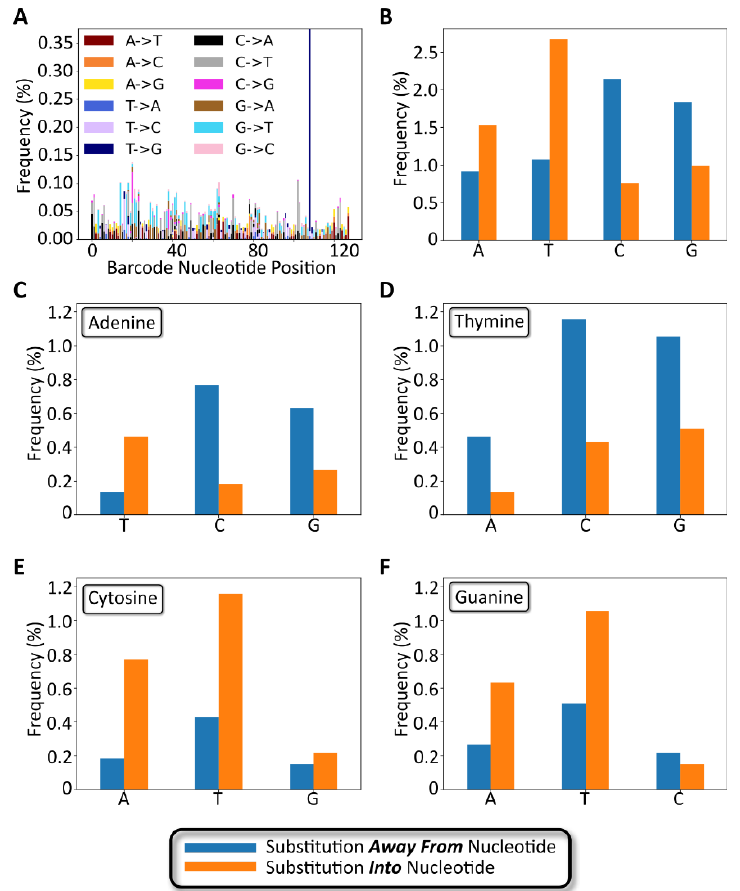
Figure 7. Gen_1 substitution variant analysis. ( A ) Stacked bar chart showing the number and type of 1-nucleotide substitutions plotted as a function of the nucleotide position along the barcode. ( B ) Bar chart showing nucleotide substitution frequency broken down by nucleotide. Blue bars represent substitutions away from the specified nucleotide. Orange bars represent substitutions to the specified nucleotide. ( C – F ) Bar charts for substitution frequency for each of the four bases, adenine, thymine, cytosine, and guanine, respectively.